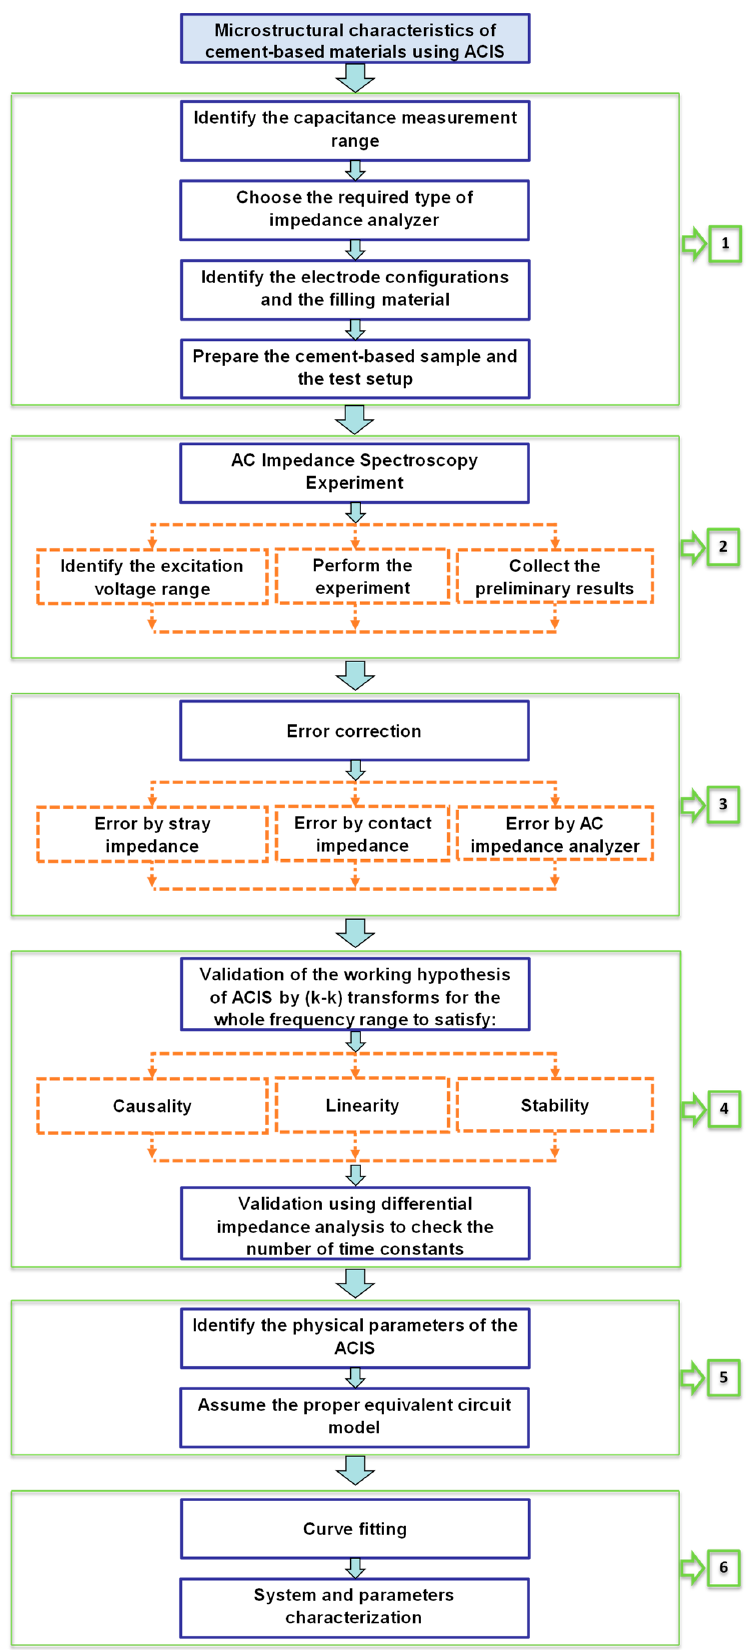
Figure 13. The cement-based microstructural analysis using